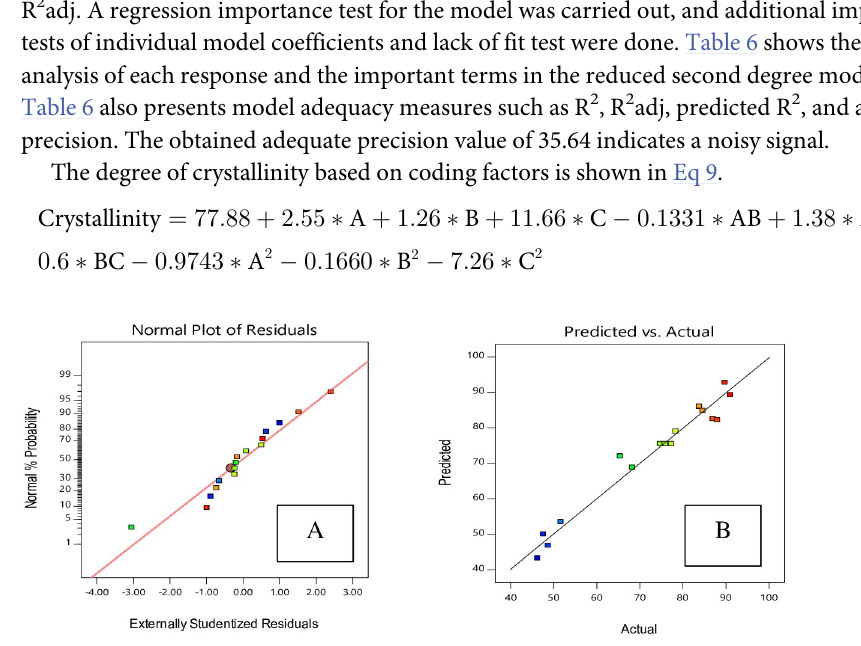
Fig 7. Residual plots for yield of HAp nano powder, based on Central Composite Design (CCD). A: normal probability; B: residuals.